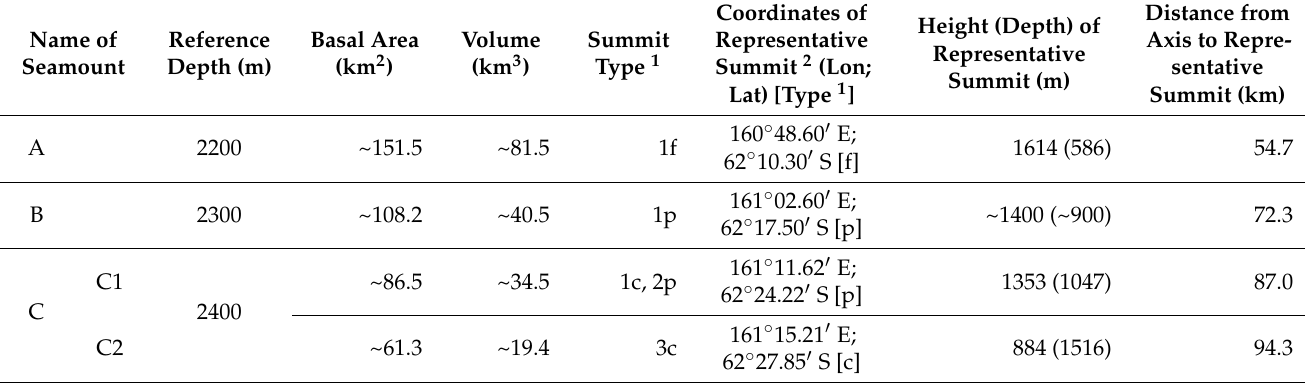
Table 1. List and estimated morphological parameters of the seamounts distributed on the flanks of